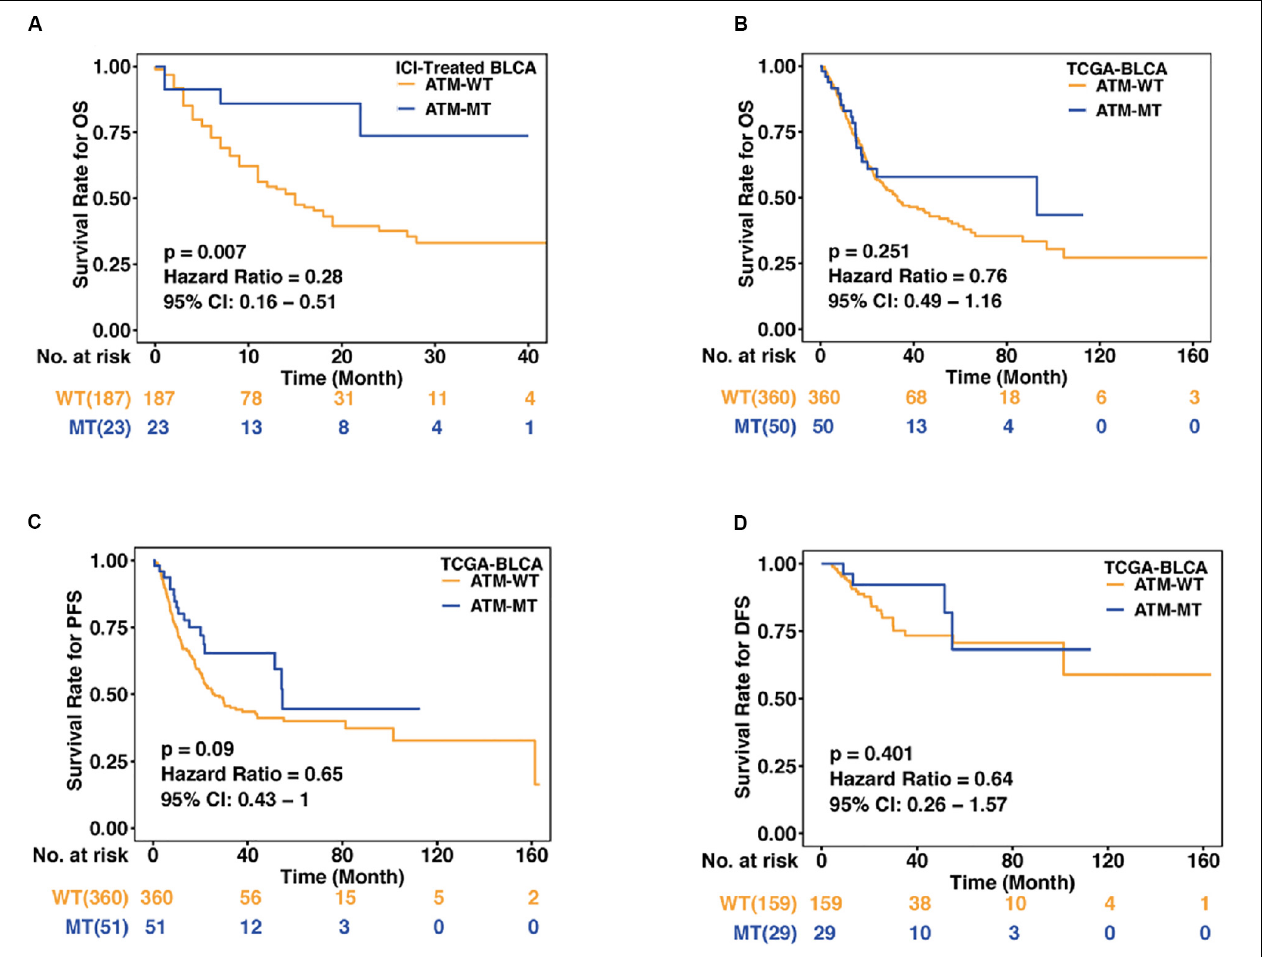
FIGURE 1 | Association between the ATM status and clinical outcomes in bladder cancer. (A) Kaplan–Meier curves comparing the overall survival (OS) of patients with ATM-MT with that of patients with ATM-WT in the immunotherapy cohort [ n = 210, hazard ratio (HR) = 0.28, [95% confidence interval (CI), 0.16 to 0.51], P = 0.007]. ATM-MT, ATM mutant type; ATM-WT, ATM wild type; BLCA, bladder cancer. (B) Kaplan–Meier curves comparing the OS of patients with ATM-MT with that of patients with ATM-WT in the TCGA-BLCA cohort ( n = 410, HR = 0.76, [95% CI, 0.49 to 1.16], P = 0.251). (C) Kaplan–Meier curves comparing the progression-free survival (PFS) of patients with ATM-MT with that of patients with ATM-WT in the TCGA-BLCA cohort ( n = 411, HR = 0.65, [95% CI, 0.43 to 1.00], P = 0.09). (D) Kaplan–Meier curves comparing the disease-free survival (DFS) of patients with ATM-MT with that of patients with ATM-WT in the TCGA-BLCA cohort ( n = 188, HR = 0.64, [95% CI, 0.26 to 1.57], P =